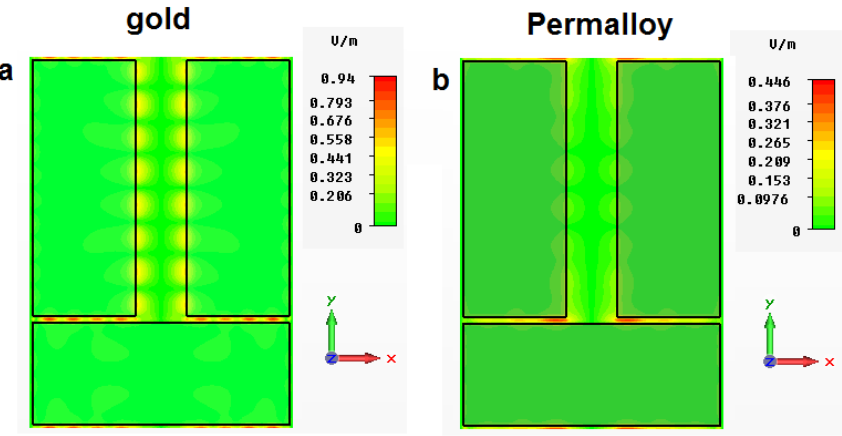
Figure 7. Simulated absolute values of the electric field in one unit cell of a periodic array of ( a ) Gold and ( b ) Permalloy dolmens with the same dimensions as in [89]. The wavelength of normally incident light is 632 . 8 nm. The width of the gaps between the individual elements of the dolmens is 50 nm. Simulations were conducted by using commercial CST Microwave Studio